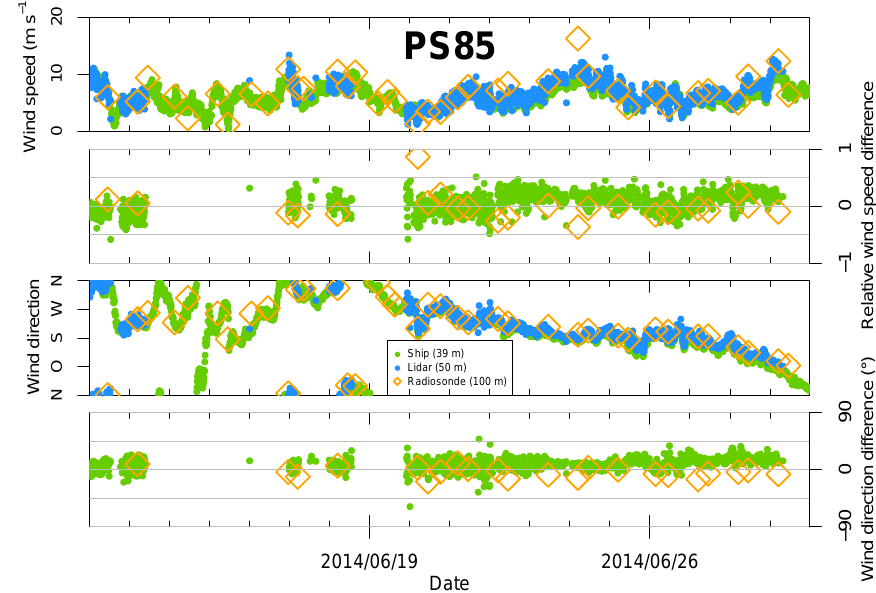
Figure 7. Comparison of wind speed and wind direction between lidar at 50m height (blue) and ship anemometer (green) for PS85. Ra- diosonde winds at 100m are marked (orange diamond) for reference. The (relative) difference is computed as lidar minus anemometer (divided by anemometer) or radiosonde (divided by radiosonde). Only scans with an elevation of 75 ◦ were used.